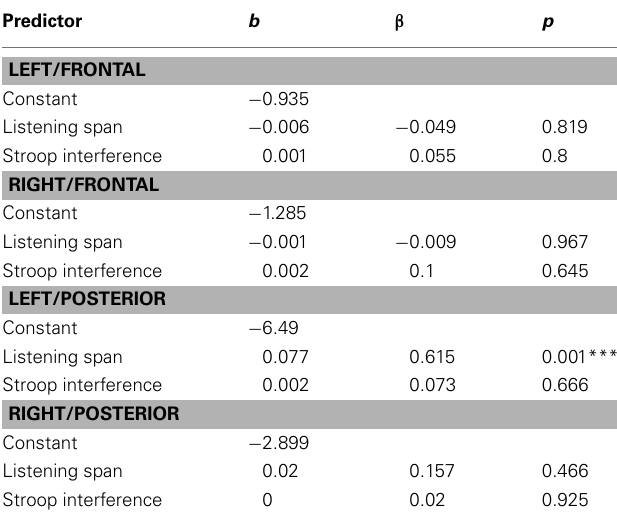
Table 6 | Multiple regression analysis of lexical association effect size (two predictors) showing unstandardized ( b ) and standardized ( β ) partial coefficients, and probability levels ( p